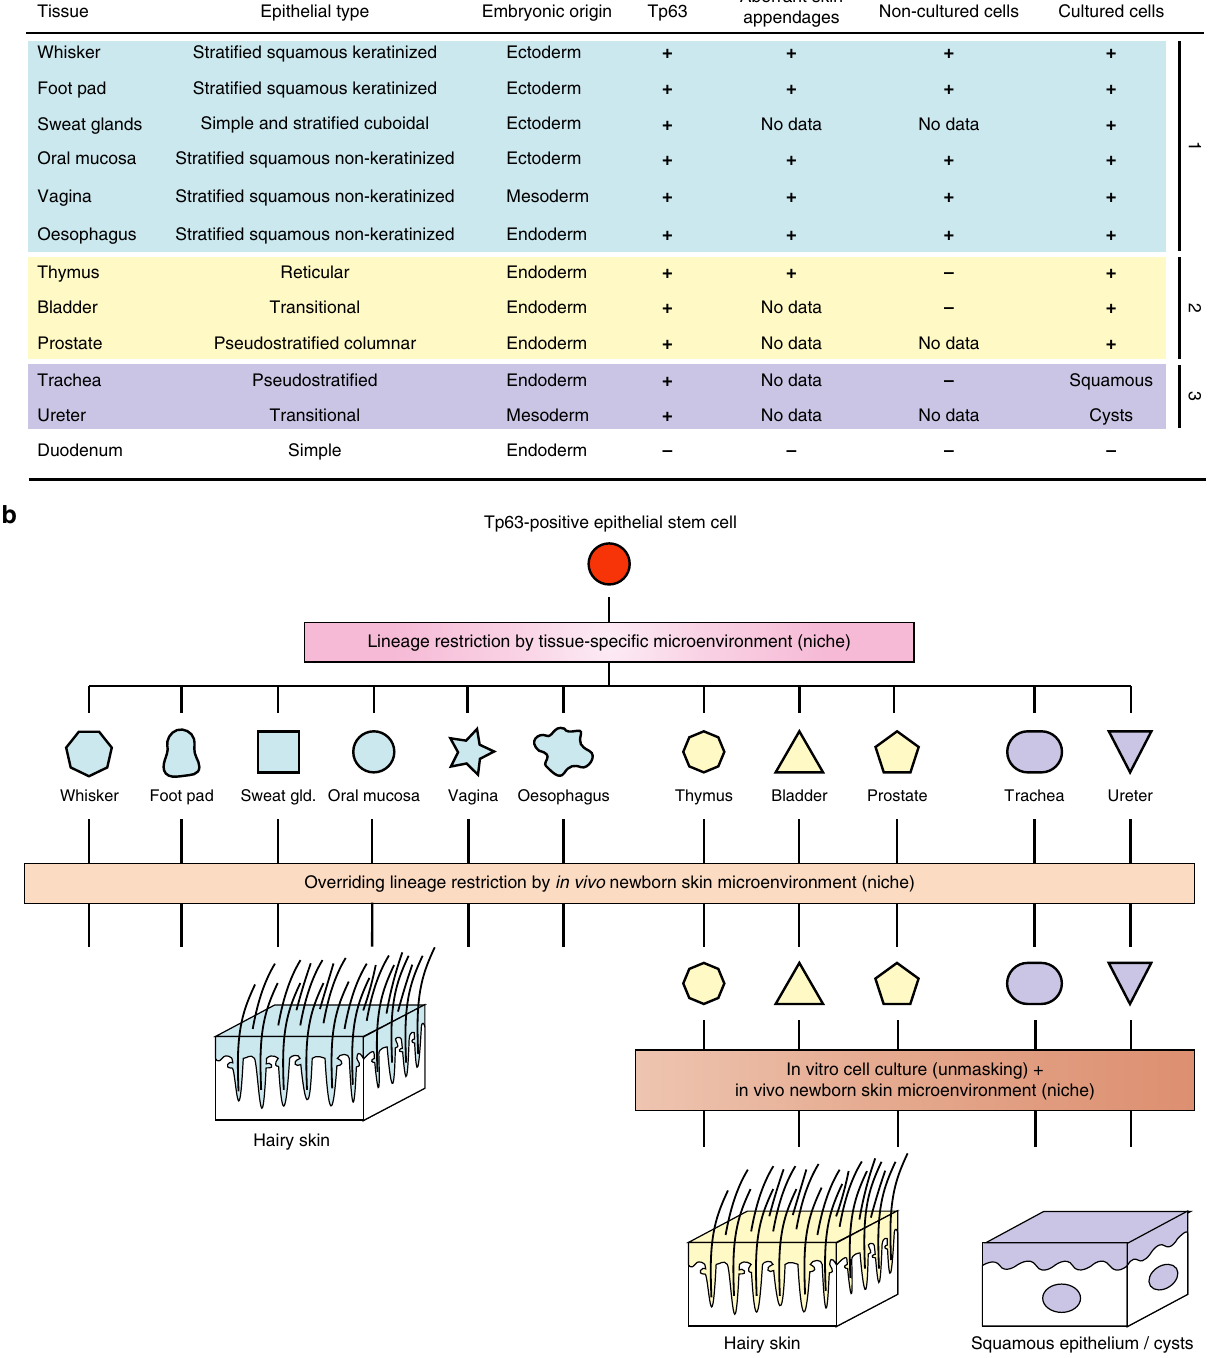
Fig. 6 Tp63-expressing epithelial stem cells can cross lineage boundaries when exposed to a hairy skin microenvironment. a Tp63-expressing epithelial stem cells can be classi fi ed in three groups depending on their response to skin morphogenetic signals. This response is independent of the embryonic origin. Group 1 includes stem cells that can behave like bona fi de hair follicle multipotent stem cells in absence of manipulation (cell culture). This may explain why the formation of aberrant hair follicles and of dermoid cysts is mostly observed in tissues lined by a squamous epithelium. Group 2 includes stem cells that can generate epidermal appendages but only after cell culture (needs unmasking). Group 3 includes stem cells that can only form